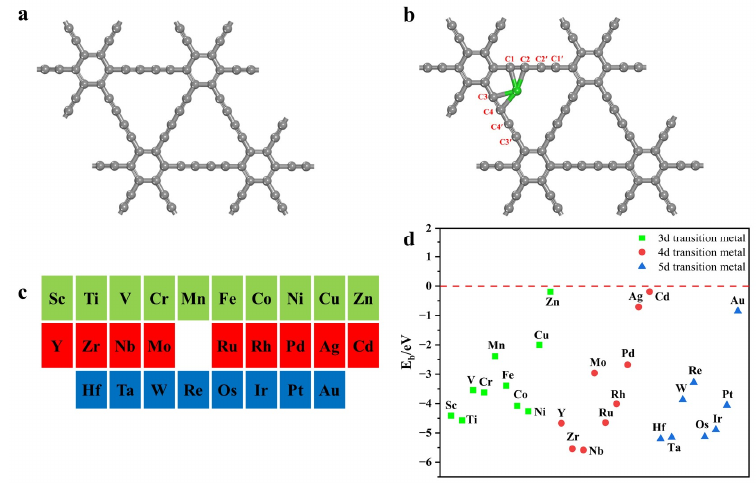
Figure 1. ( a ) Structure of GDY monolayer. ( b ) Structure of TM 1 @GDY single-atom catalyst with different C sites labeled. Gray represents C atoms while green represents transition metal atoms. ( c ) The transition metal atoms investigated in this work. ( d ) Calculated binding energy (E b ) of TM 1 over different TM 1 @GDY.